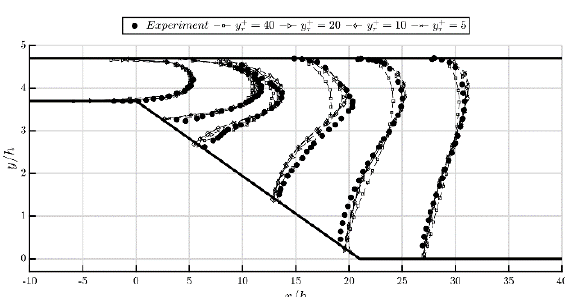
Figure 10. Plane diffuser lower wall distribution of coeffi– cient of pressure.